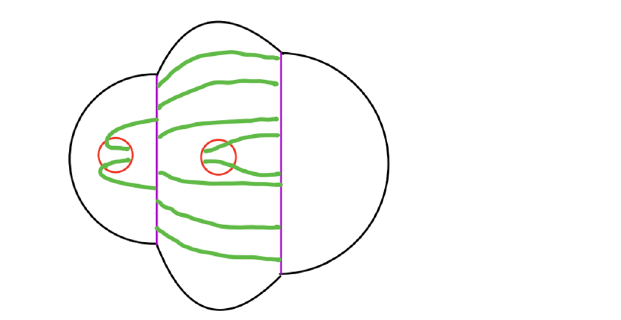
Figure 13 . Bit-threads emitted from the horizons can thread the Einstein-Rosen bridge connecting the black holes.